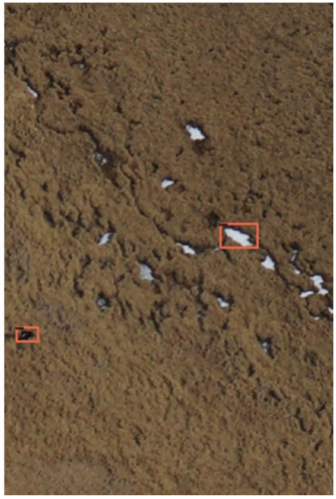
Figure 8. An example of where a detection frame obtained by mistakenly detecting snow as Tibetan sheep needs to be removed (the red boxes in the figure are the detection result boxes of the original Faster-RCNN